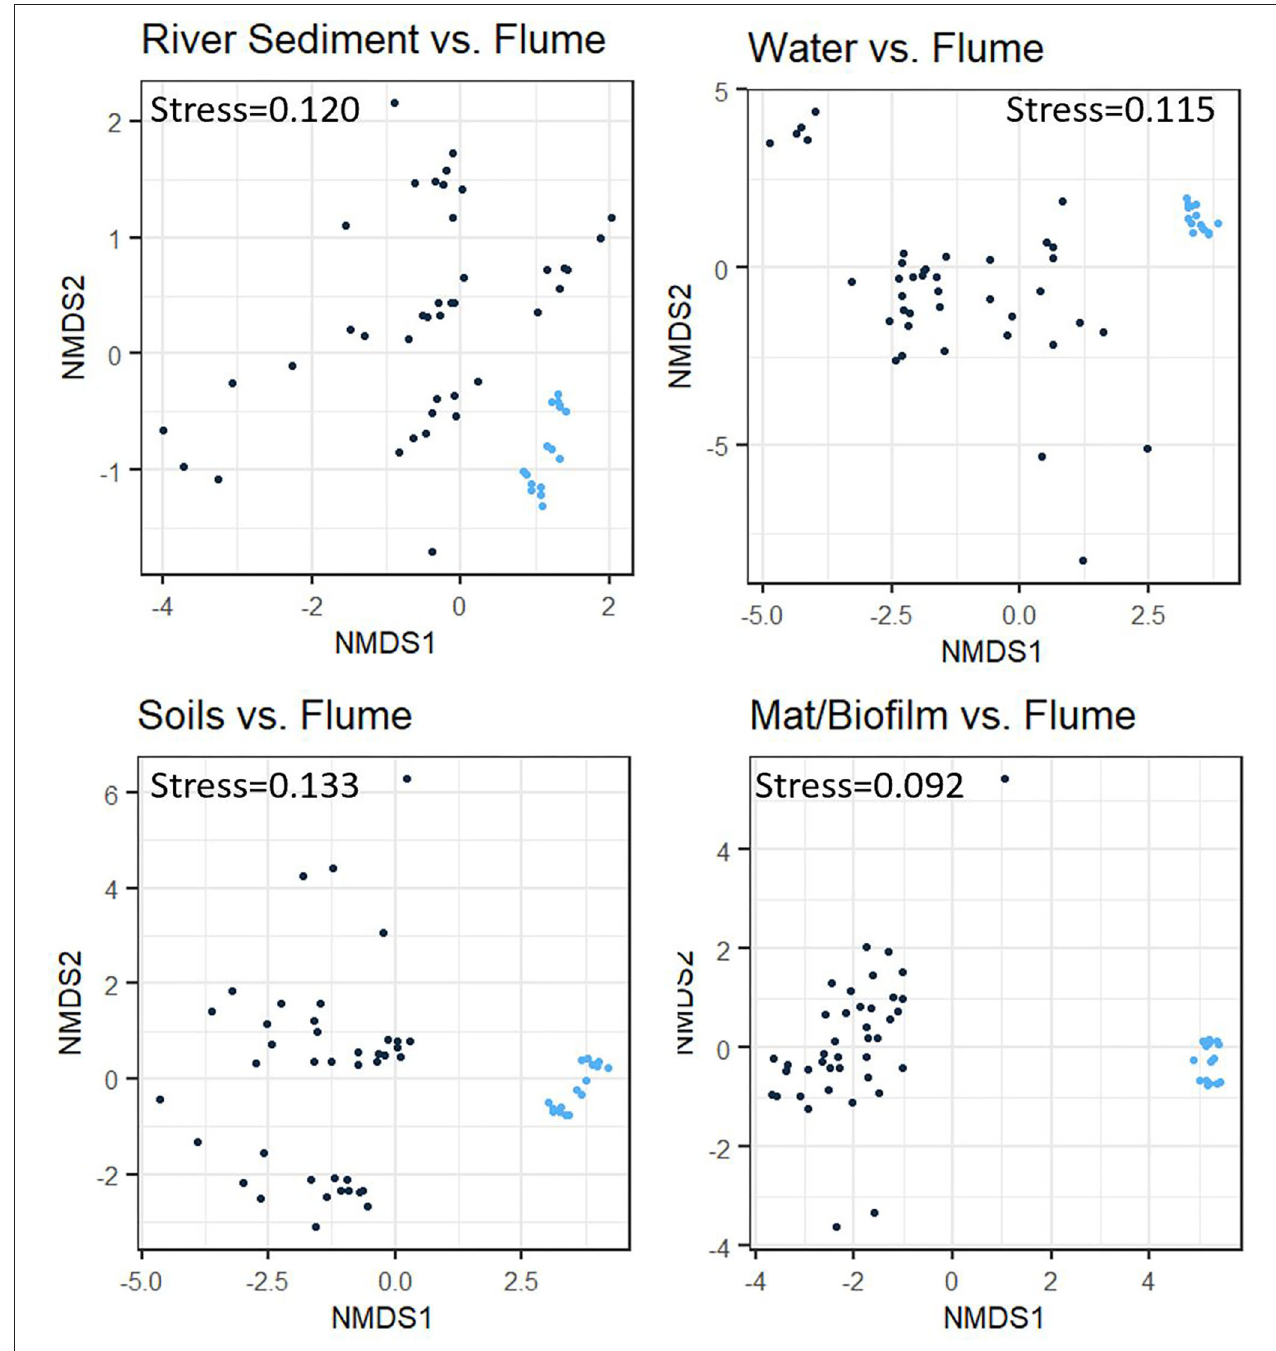
FIGURE 5 | Non-metric multidimensional scaling (NMDS) plots comparing samples from various natural environment groups to experimental flume samples using Bray-Curtis dissimilarity. Each panel represents clustering between the flume samples (blue dots) and one other comparison environment group (black dots) identified by the individual plot title. The flume samples cluster somewhat independently of the comparison environment groups in all cases, but this is more apparent in the comparison with the soil and microbial mat/biofilm environment groups than it is in the river sediments or water environment groups.